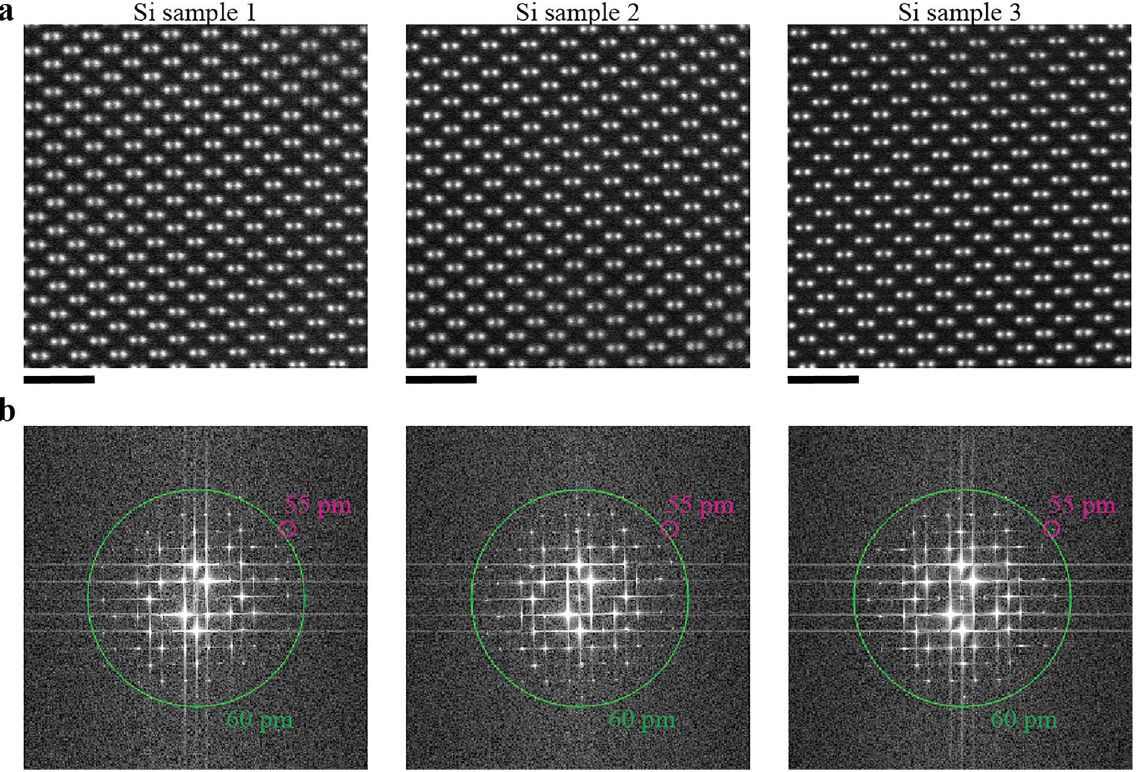
Figure 4. Aberration-corrected STEM imaging of the three Si lamellae. ( a ) Atomic-level HAADF-STEM images of each lamella along the [110] direction acquired by aberration-corrected STEM (same samples as Fig. 3). Images were acquired near the thin bottom edge of each sample. Equivalent HAADF-STEM images from near the top protective layer are shown in Supplementary Fig. S5. ( b ) FFT patterns for each image. Magenta circles indicate FFT reflections at 55 pm resolution. Green circles correspond to 60 pm resolution. The scale bar is 1 nm.